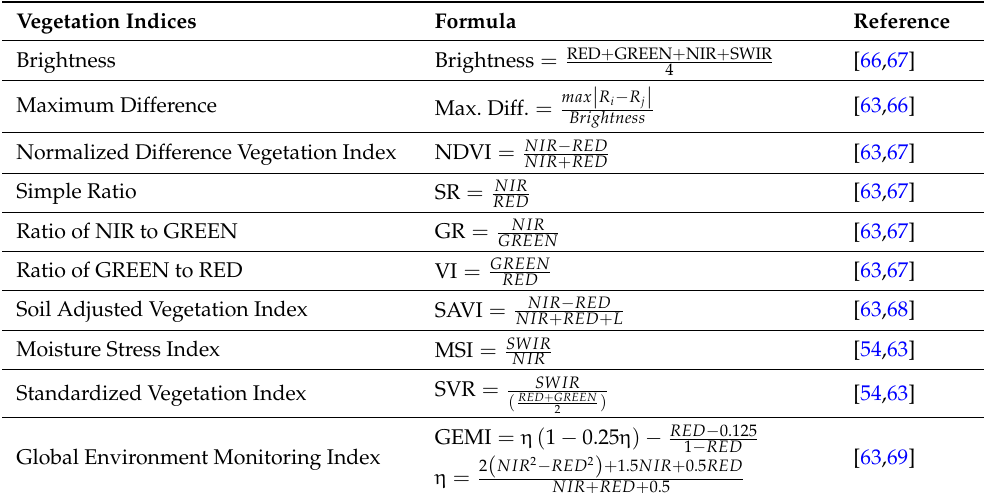
Table 1. Spectral vegetation indices derived from the SPOT-5